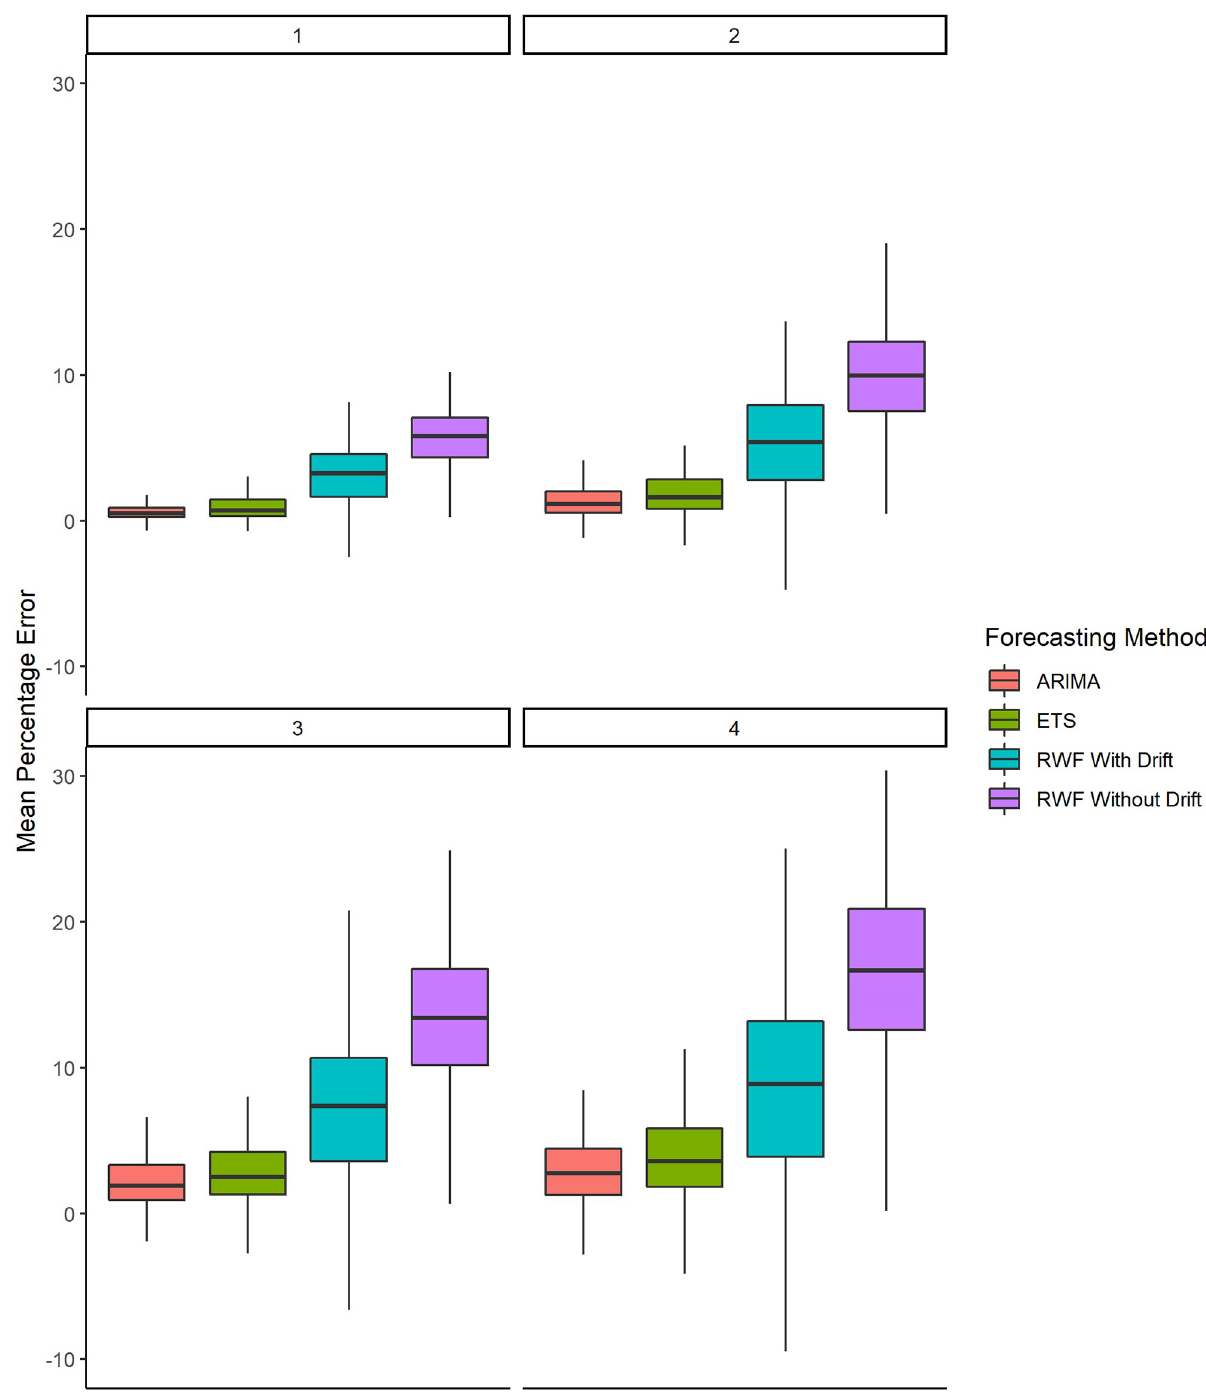
Fig 4. Boxplots of the MPE results (without the outliers) for 187 countries and at the aggregated level of the world.